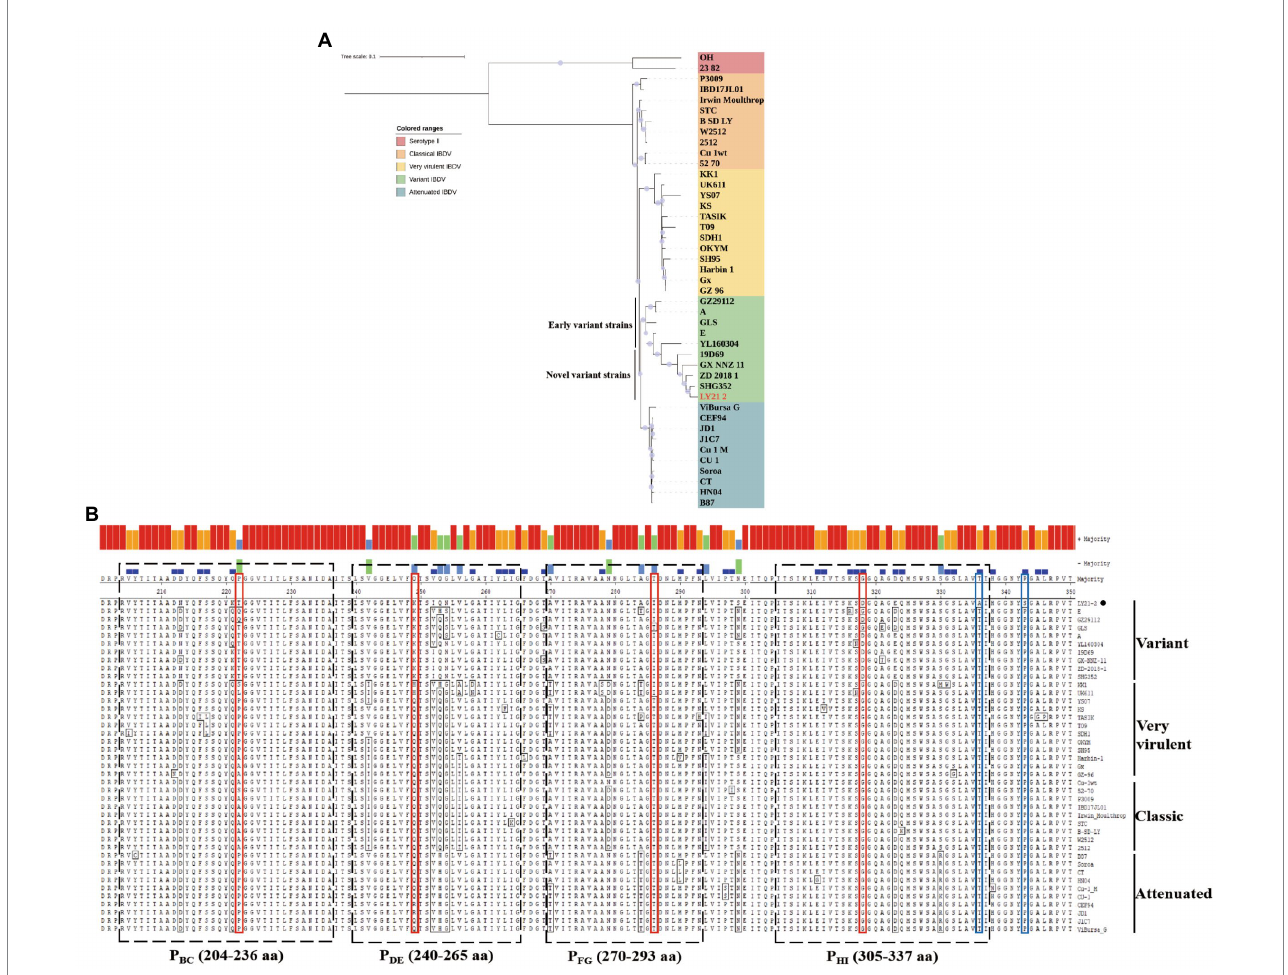
FIGURE 2 Molecular Characteristics of the VP2 gene. (A) Phylogenetic analysis based on the nucleotide sequences of VP2 by MEGA X software v6.4. The phylogenetic tree represented the isolate LY21/2 formed one branch with novel variant IBDVs. The confidence levels were assessed using 1,000 bootstrap replications. The strain LY21/2 is indicated by red font. (B) The amino acid sequences in the HVR (206–350 aa) of LY21/2 VP2 were compared with variant strains, classic strains, attenuated strains and very virulent strains. The red boxes represent the characteristic amino acid residues (222 T, 249 K, 286I, and 318D). The blue boxes represent two different amino acid residues (336A and 343S) compared to other reference strains. LY21/2 is shown with a black